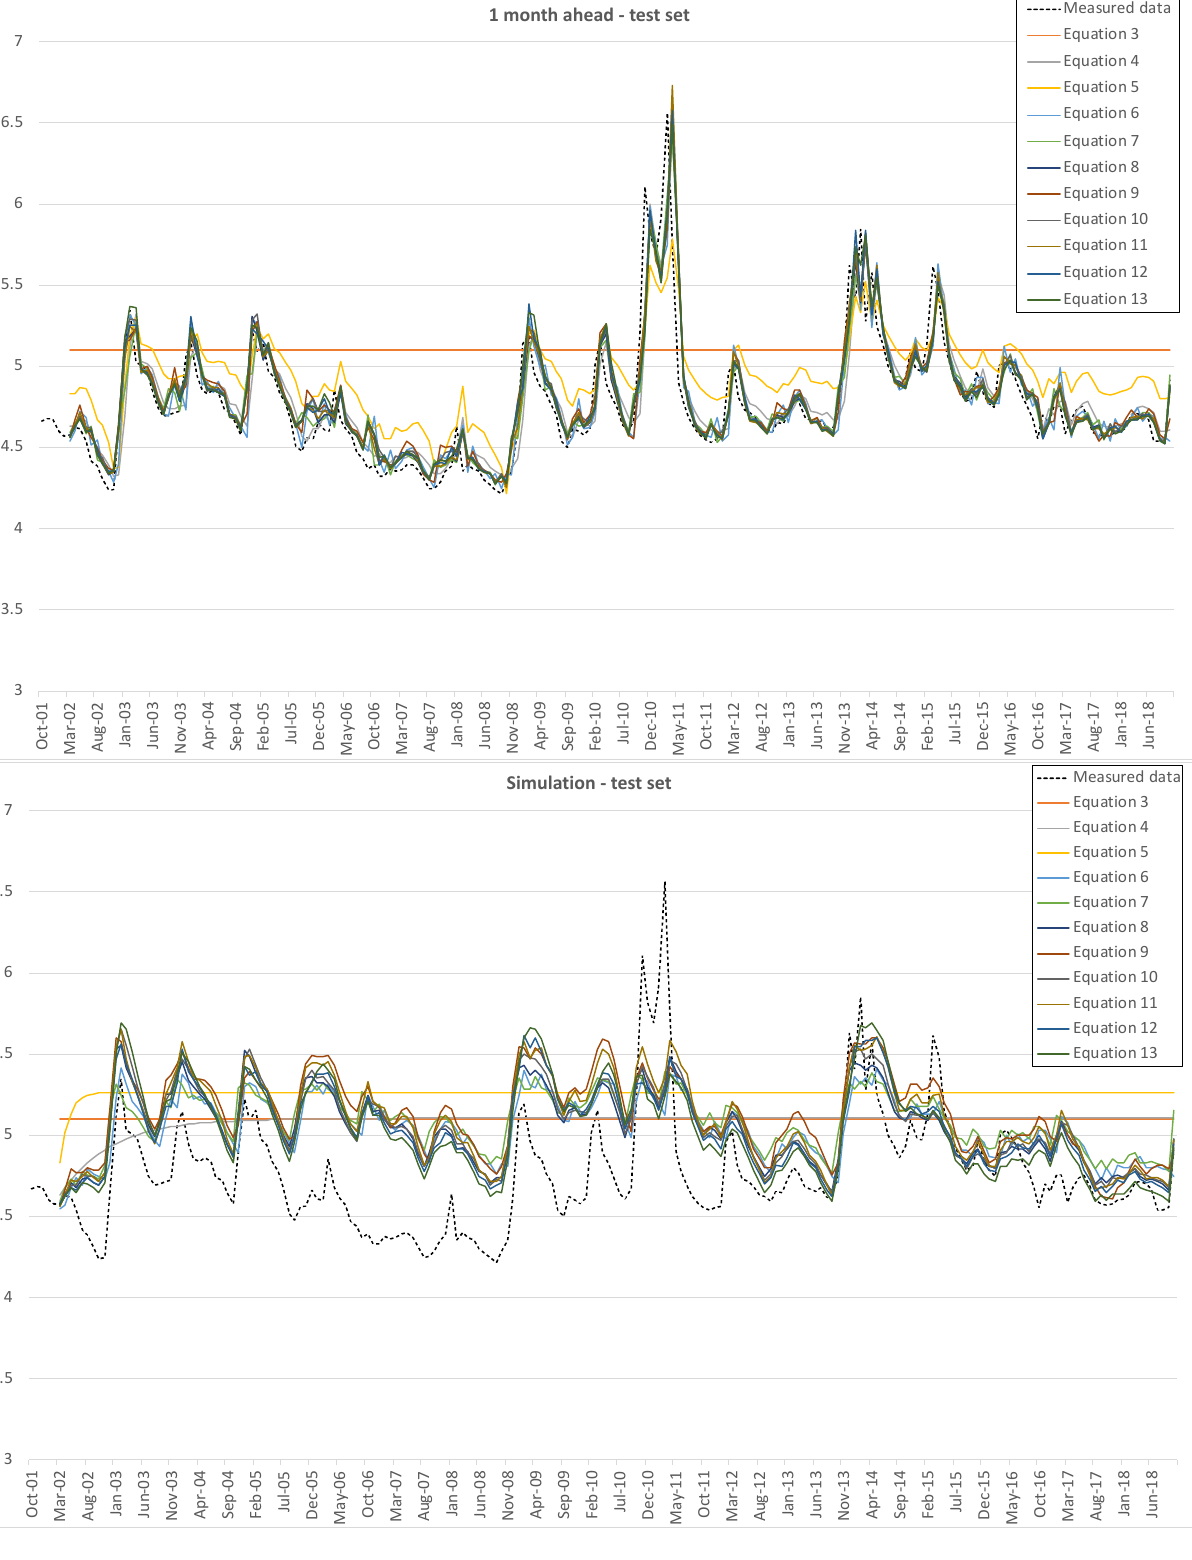
Figure 5. One month ahead prediction and simulations of EPRMOGA returned models for the training set, i.e., Terra Montonata, piezometric levels on the vertical axis are in m a.s.l.